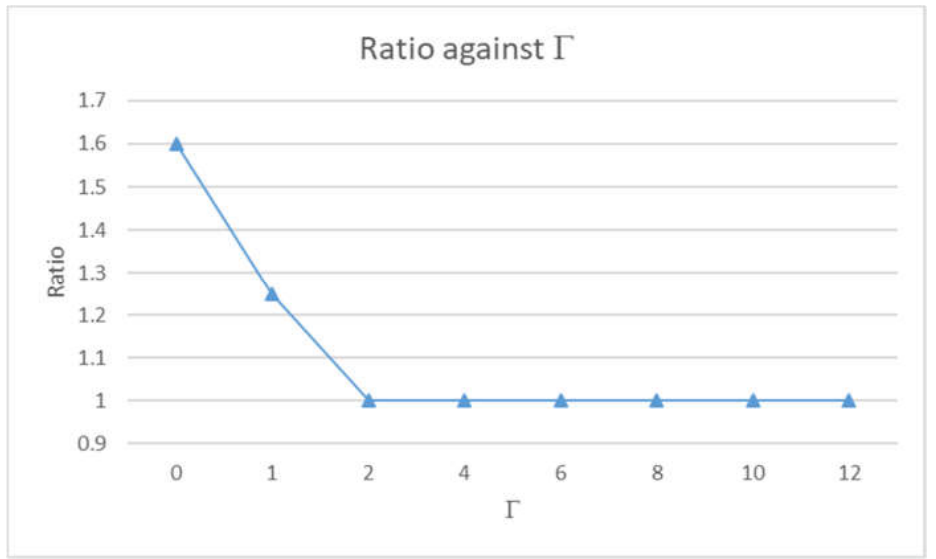
Figure 3. The ratios of the total cost from deterministic model to the total cost from modified robust model with respect to Γ .